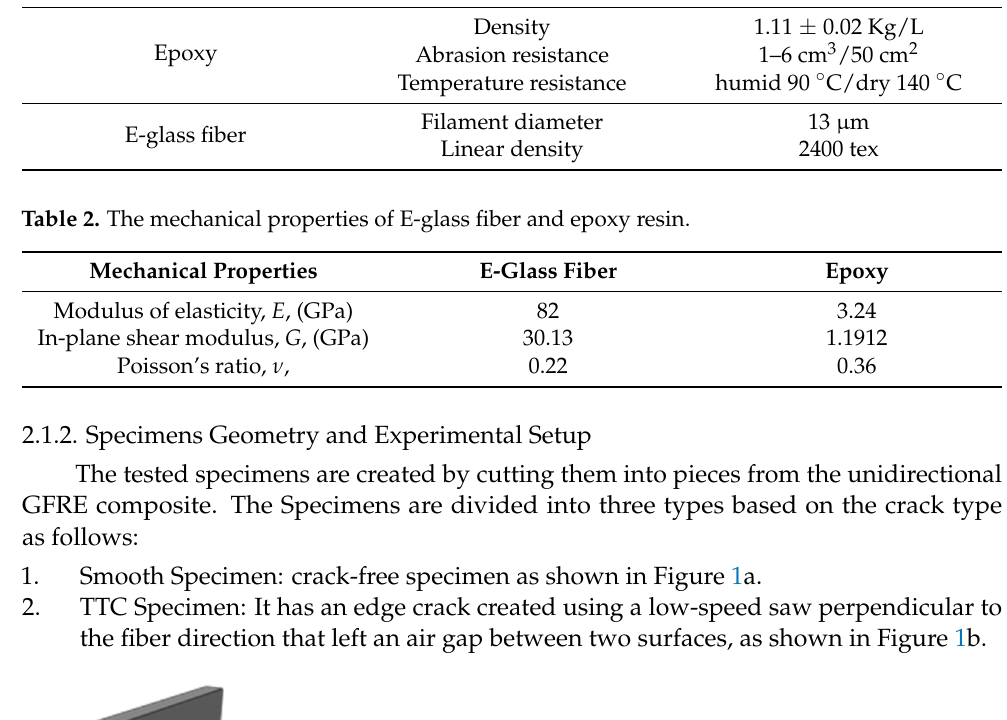
Figure 2. Preparation of matrix crack by wax and DMF.